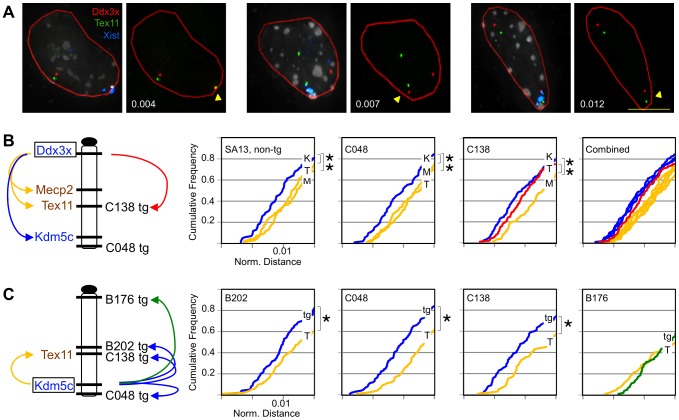
Transgenes assume frequent long-range escape-gene interactions.(A) Representative C138 nuclei compressed from 3D-image stacks hybridized to detect BAC DNA and Xist RNA. Arrowhead denotes inactive X. Normalized distances indicated (µm/µm2) reflect inactive X, 3D-probe distances (0.32, 0.89, and 1.33 µm) normalized to nuclear area (red outline). (B,C) Chromosome location of transgenes and BAC probes. BACs tested include X-inactivated genes Mecp2 (M) and Tex11 (T) (yellow/brown) or escapee Kdm5c (K) (blue). (B) Cumulative frequency curves show loci scored relative to Ddx3x. The shifted Ddx3x-Tex11 curve in C138 (red) reflects transgene association in the subset of cells that inactivate the transgenic X. (C) Inactive X distances between Kdm5c and Kdm5c-tg (tg) are compared to endogenous Kdm5c and Tex11 (T) on the non-transgenic X. B176 (green) lacks an expressed Kdm5c-tg. All plots include the 60–80% of cells with closest probe distances (complete data in Figure S5). Each probe comparison includes 100–150 nuclei. *p<0.02.